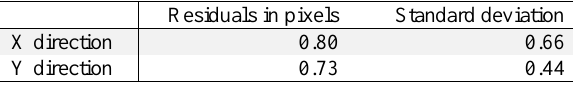
Table 1. Geometric accuracy of a real-time